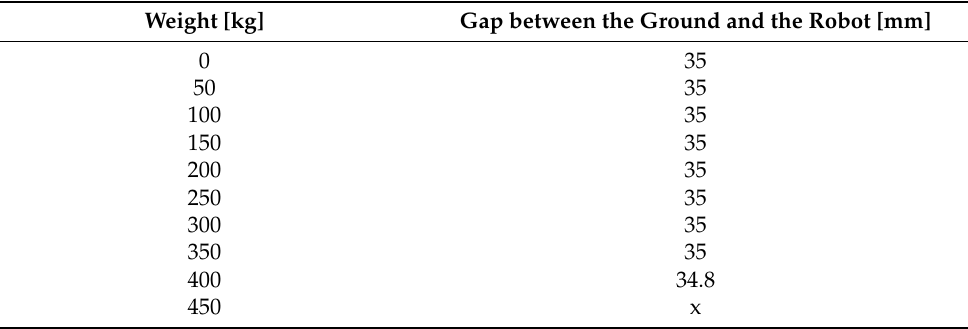
Table 4. The case of a front concentrated load. Weight [kg] Gap between the Ground and the Robot